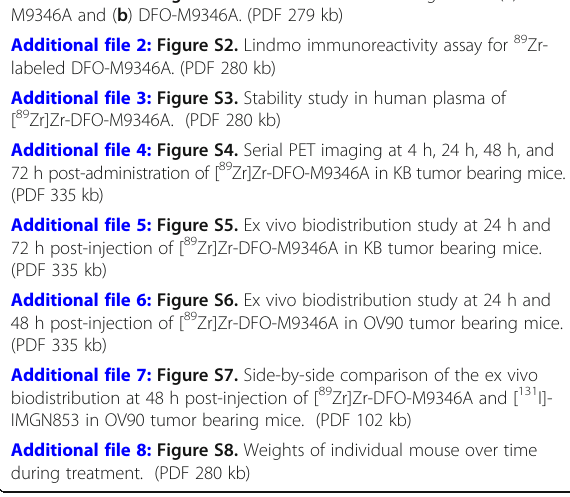
Additional file Additional file 1: Figure S1. Size exclusion chromatograms of ( a ) M9346A and ( b ) DFO-M9346A. (PDF 279 kb) Additional file 2: Figure S2. Lindmo immunoreactivity assay for 89 Zr- labeled DFO-M9346A. (PDF 280